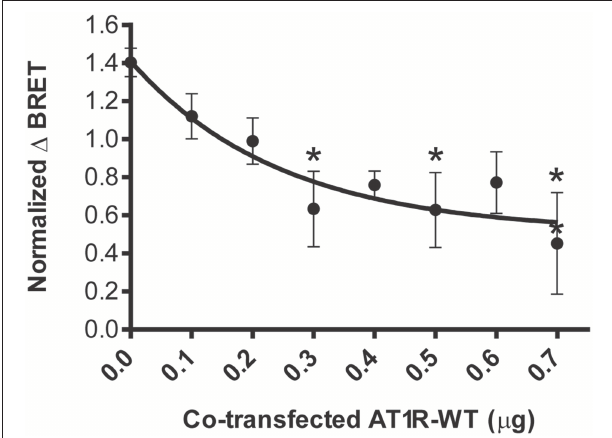
FIGURE 2 | Specificity of the PGF2 α -induced β -arrestin 2 recruitment to the AT1R/FP dimer. The recruitment of β -arrestin 2-RlucII to the AT1R-Venus (0.3 µ g)/FP-WT (0.1 µ g) dimer (fixed amount) induced by PGF2 α (1 µ M) was titrated by co-transfecting increasing amounts of AT1R-WT (0.0–0.7 µ g). Increased expression of AT1R-WT competed with AT1R-Venus for dimerization with FP-WT, reducing the capacity of the AT1R-Venus/FP-WT dimer to recruit β -arrestin 2-RlucII. Data were normalized for AT1R-Venus expression and represent mean ± s.e.m. of independent experiments [biological replicates each performed in triplicate ( n = 3–5)]. * p < 0.05, compared to AT1R-WT (0.0 µ